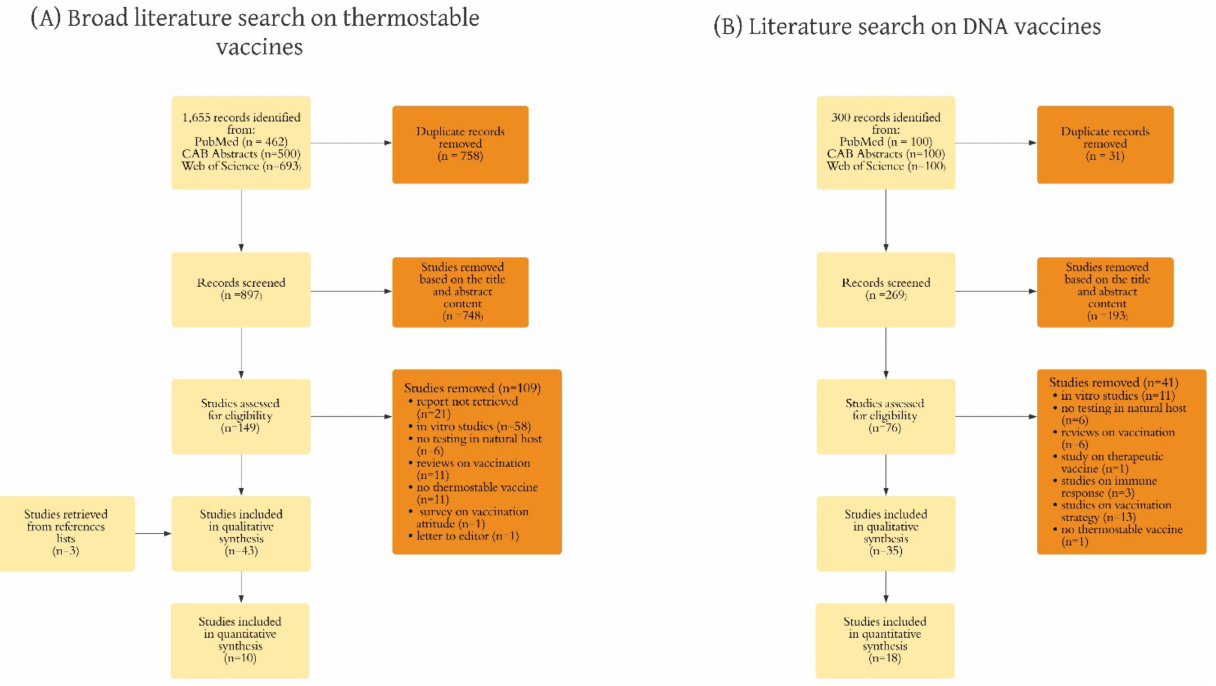
Figure 1. Diagram showing the stepwise process of study selection and pre-determined inclusion and reasons of exclusion for the broad search on thermostable vaccines ( A ), and the literature search on DNA vaccines ( B